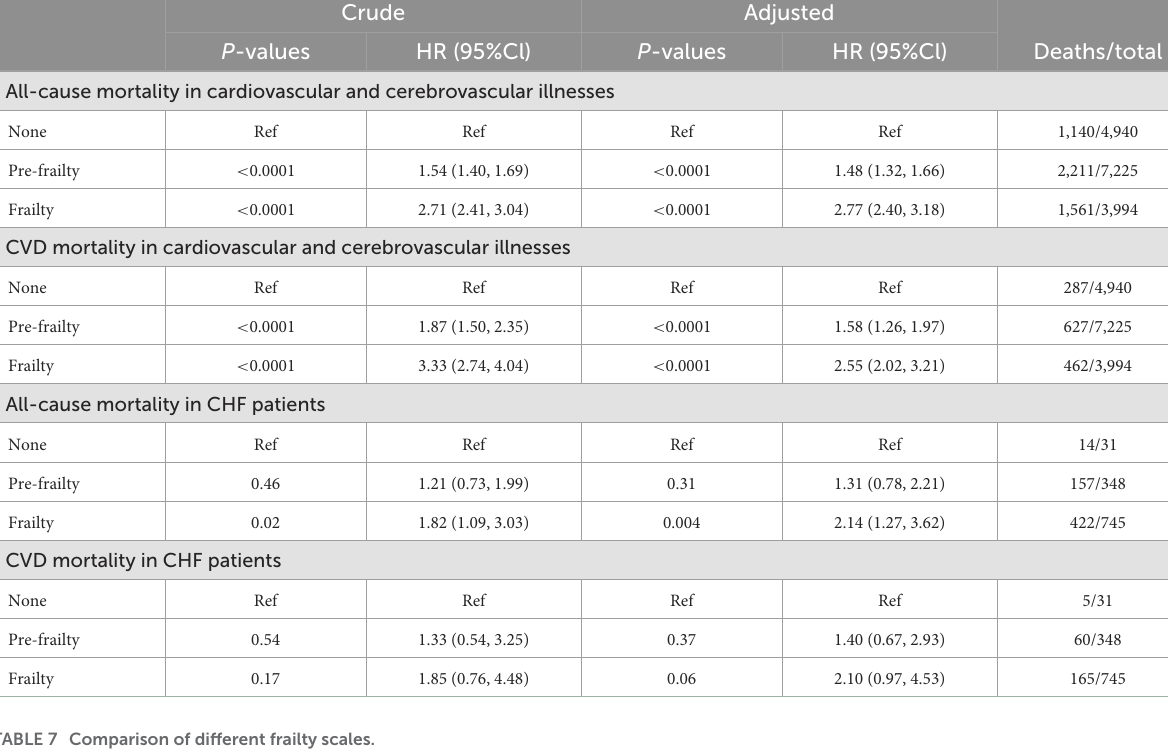
TABLE 7 Comparison of different frailty scales. Scale Strengths Weaknesses Cumulative deficit